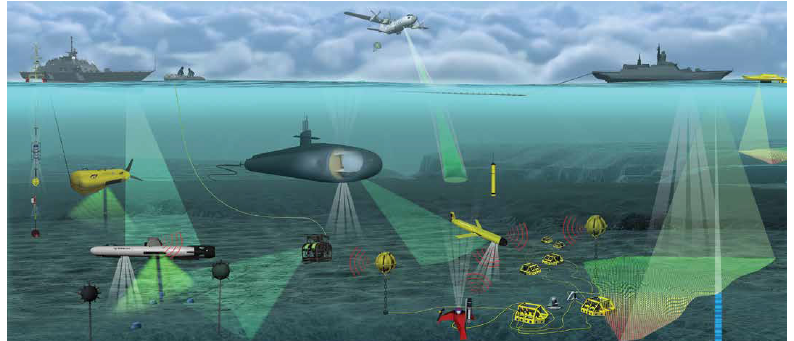
Figure 5. The communication between the autonomous underwater vehicle with the unmanned aerial-aquatic vehicle